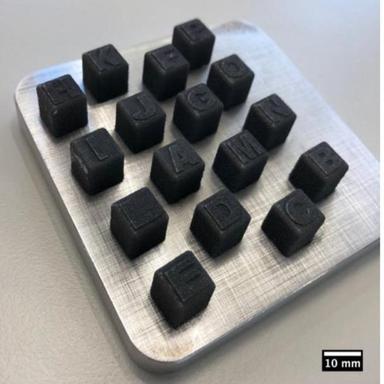
LPBF fabricated specimens of Al-14Zn-3Mg with different processing parameters (microstructures of which are presented in).